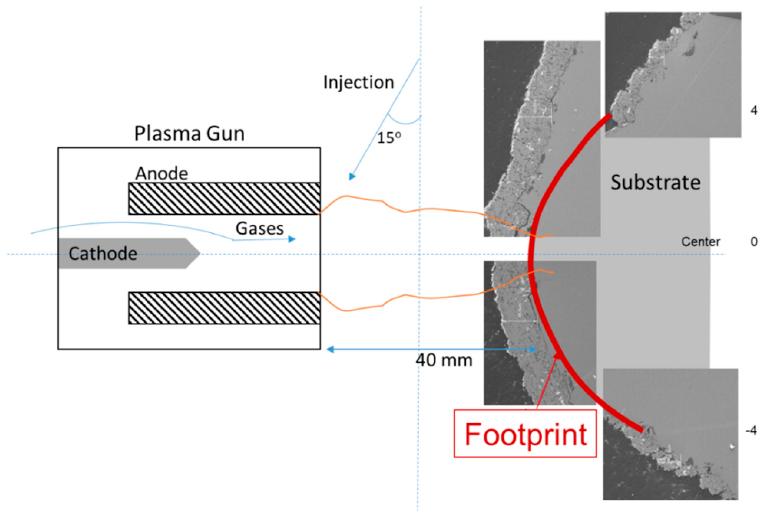
Figure 10. Spray setup for a rod sample.